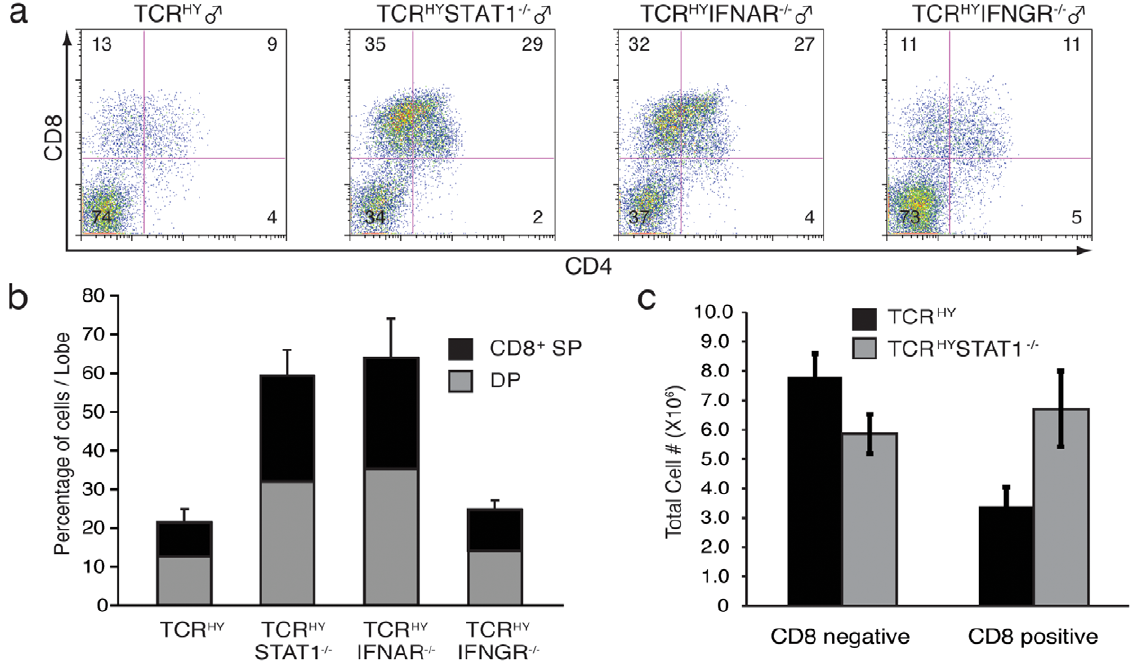
Figure 1. STAT1 and IFNAR are required for elimination of self-reactive TCR HY thymocytes. ( a ) Thymocytes from male TCR HY , TCR HY STAT1 2 / 2 , TCR HY IFNAR 2 / 2 , and TCR HY IFNGR 2 / 2 mice were gated on TCR HY positive cells and analyzed for CD4 and CD8 expressing subpopulations. ( b ) Graph represents percentages of CD8 + single-positive (SP) cells (black) and CD4 + CD8 + double-positive (DP) cells (gray) derived from thymi of TCR HY transgenic male mice. Results shown represent averages and standard deviations of three to five experiments. (c) Total numbers of CD8 2 and CD8 + TCR HY thymocytes from the indicated mice.